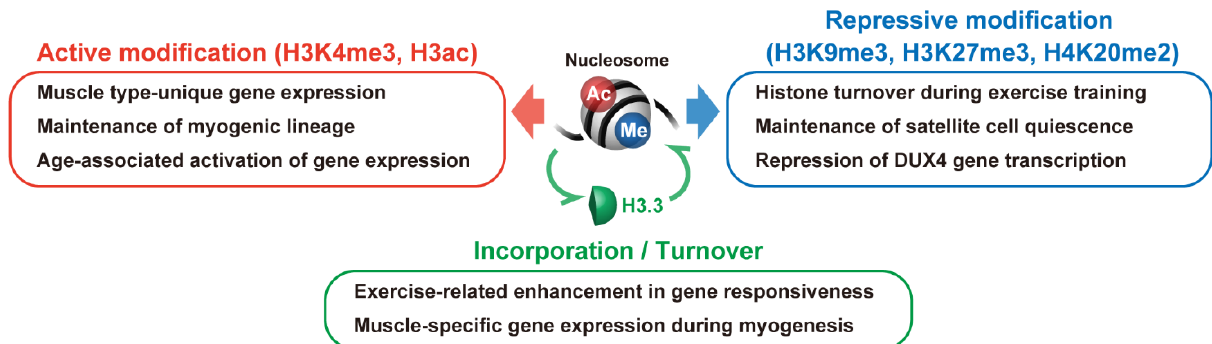
Figure 6. Roles of histone modifications in skeletal muscle. The roles of active and repressive histone modifications, and incorporation of newly synthesized histone, such as H3.3, into nucleosome and its exchange (turnover) are illustrated on the basis of this review.